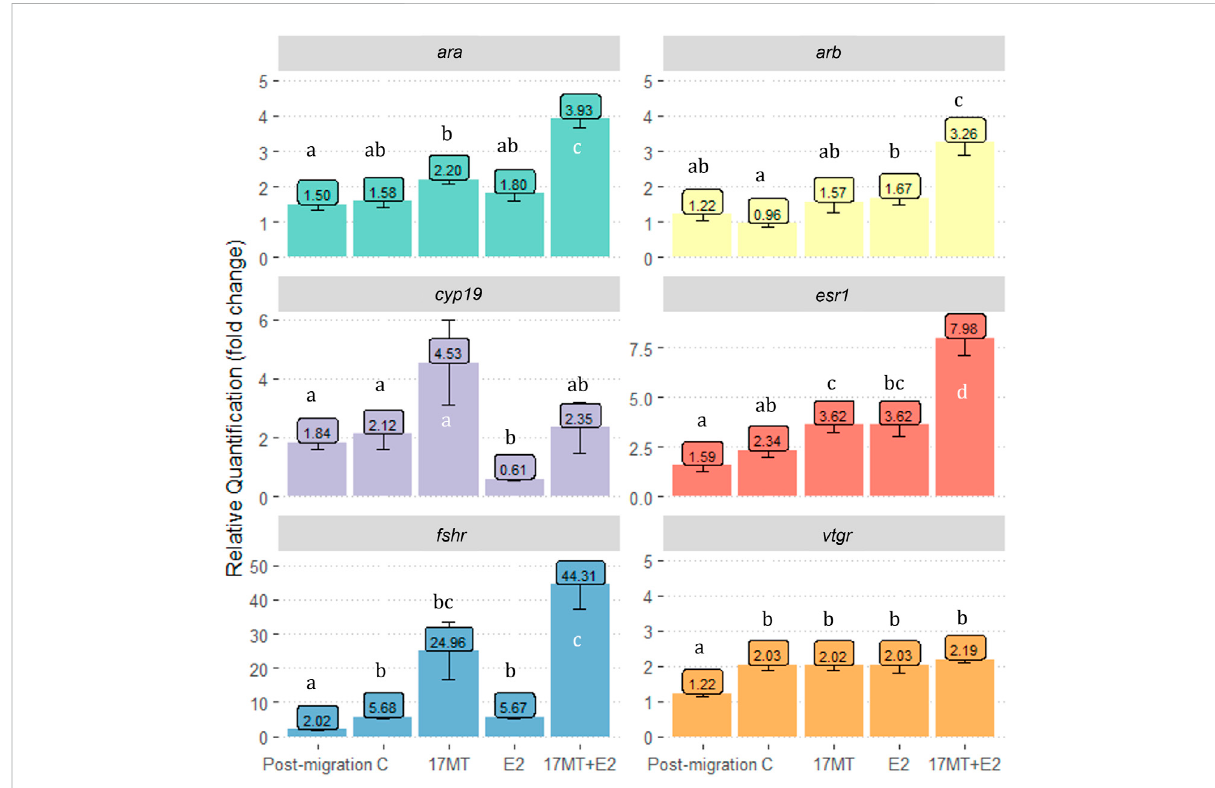
FIGURE 7 Gene expression of gonad androgen receptor- α ( ara ); androgen receptor- β ( arb ); P450 aromatase (c yp19 ); estrogen receptor 1( esr1 ); follicle- stimulatinghormonereceptor( fshr )andvitellogeninreceptor( vtgr ).Geneexpressionisshownasrelativequanti fi cationin “ foldchange ” ascompared to gene expression in the pre-migration group. Pre- ( N = 5) and post-migration ( N = 5); control (C group; N = 5); 17 α -methyltestosterone (17 MT group; N = 5); 17 β -estradiol (E2 group; N = 5), and co-implanted 17 MT and E2 (17 MT + E2 group; N = 5).